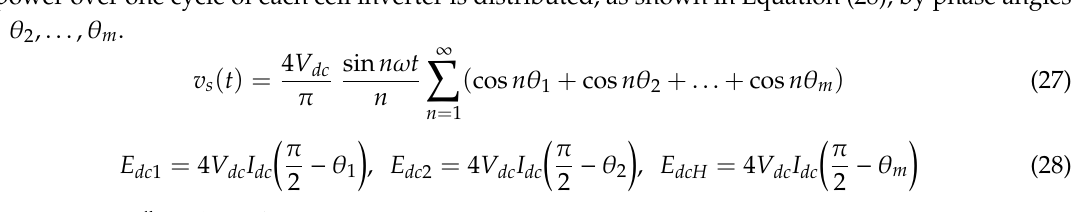
Figure 12. Waveforms and switching method of n-level cascade inverter.